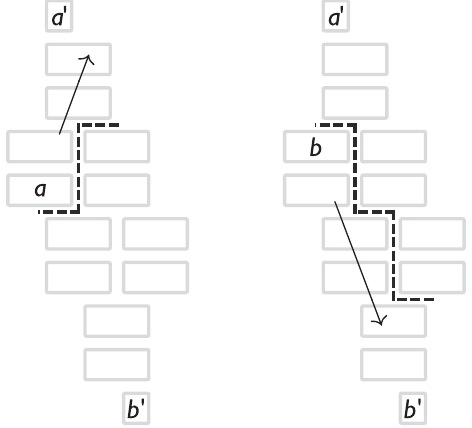
FIG. 20. A partially contracted diagram for the OTOC at t ¼ 2 in the block representation. The choice of an A contraction (or a B contraction) of blocks on the leftmost bond forces blocks in the upper (lower) light cone (dashed lines) to have the same type of contraction. Otherwise, the diagram has an order bounded by q − 1